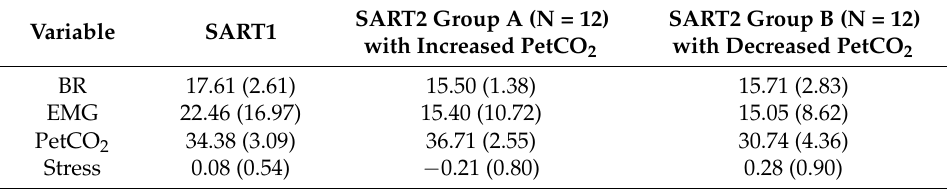
Table 2. SART2 test results—mean and standard deviation for each